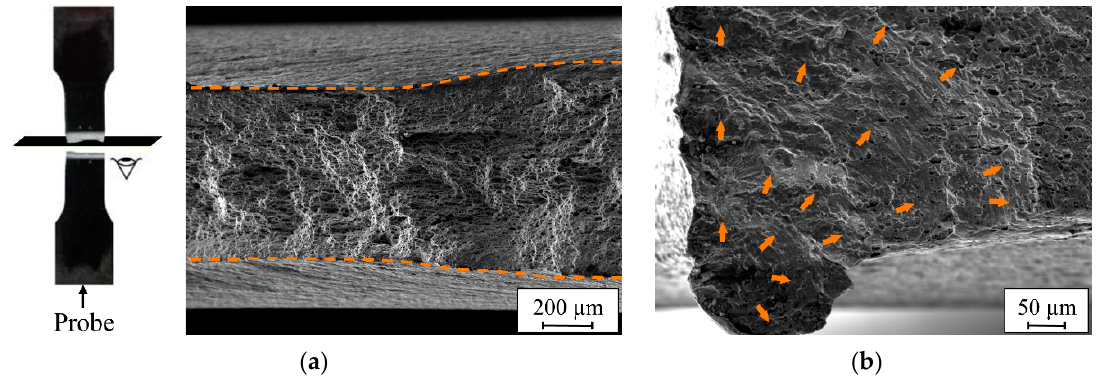
Figure 22. The fracture mechanisms of the finished specimens: ( a ) cyclic creep and ( b ) fatigue fracture.